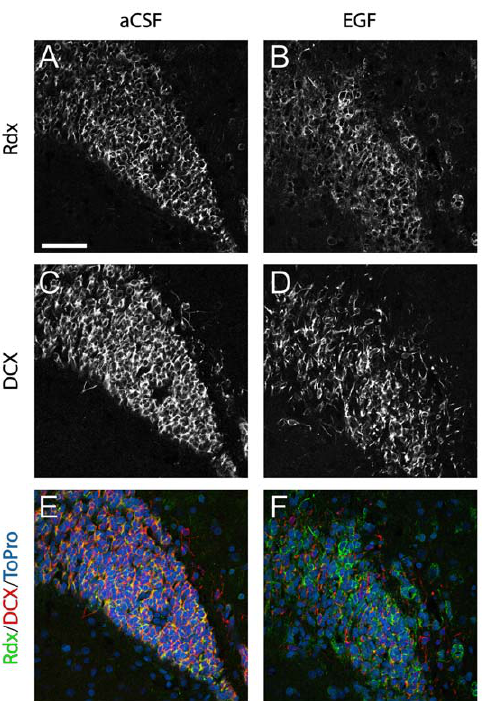
Figure 3. Radixin and doublecortin protein expression in the rostral migratory stream. Immunofluorescence staining illustrating radixin (Rdx) and doublecortin (DCX) expression in coronal sections of the rostral migratory stream (RMS) after 7 days of aCSF or EGF infusion. ( A, B ) Color separation for radixin, ( C, D ) color separation for DCX, ( E, F ) color composite images of radixin (green), DCX (red) and the nuclear counterstain ToPro3 (blue). The high degree of DCX/radixin colabeling in controls (yellow labeling in E) is notably reduced in EGF infused animals. Scale bar in A=50 m m.